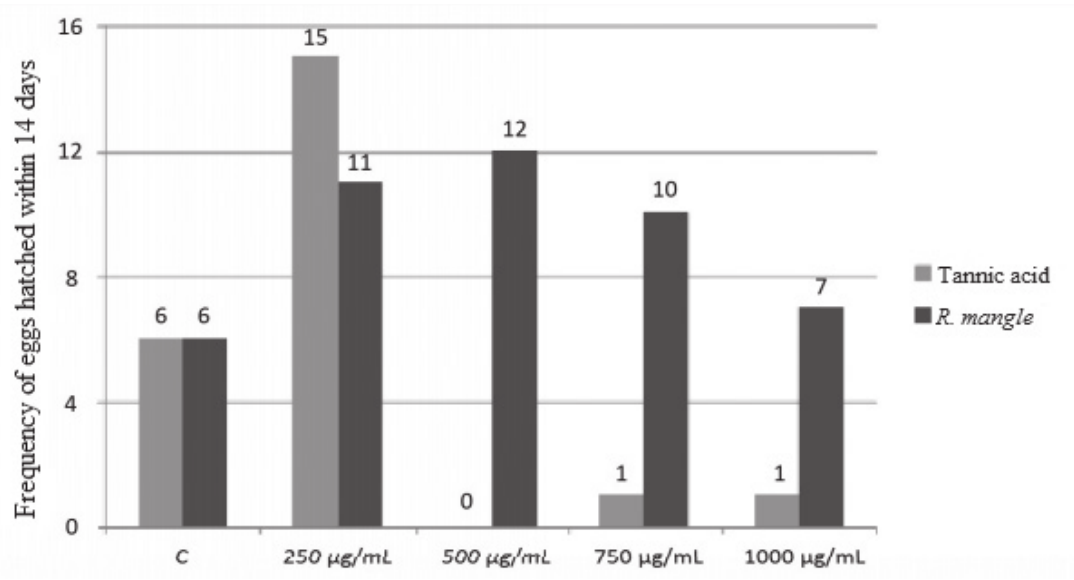
Figure 1 - Frequency of egg hatchability during 14 days on aqueous extract of R. mangle and tannic